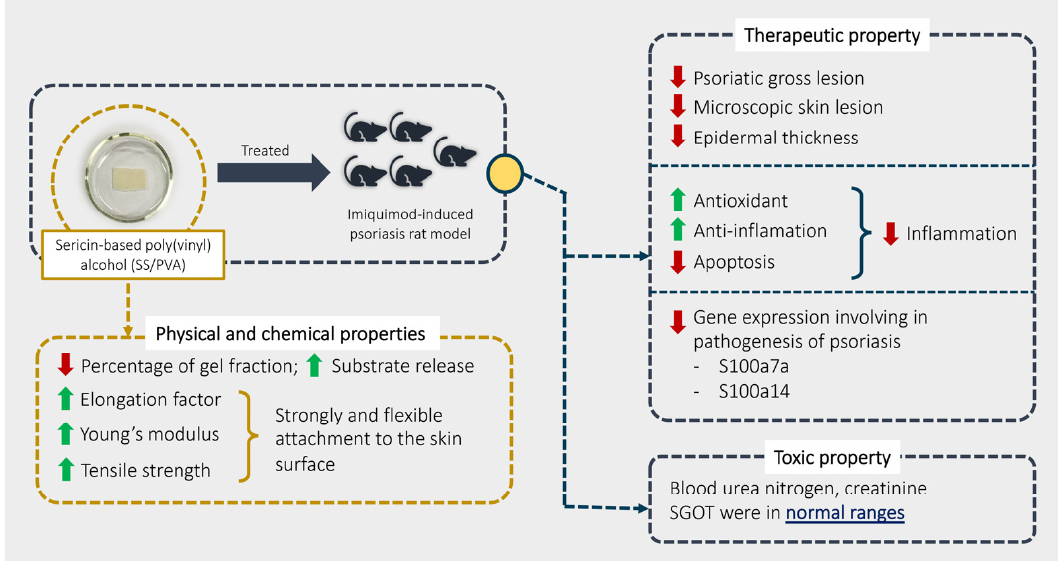
Figure 6. Summary of the physical and chemical properties of SS/PVA and its therapeutic and toxic effects.